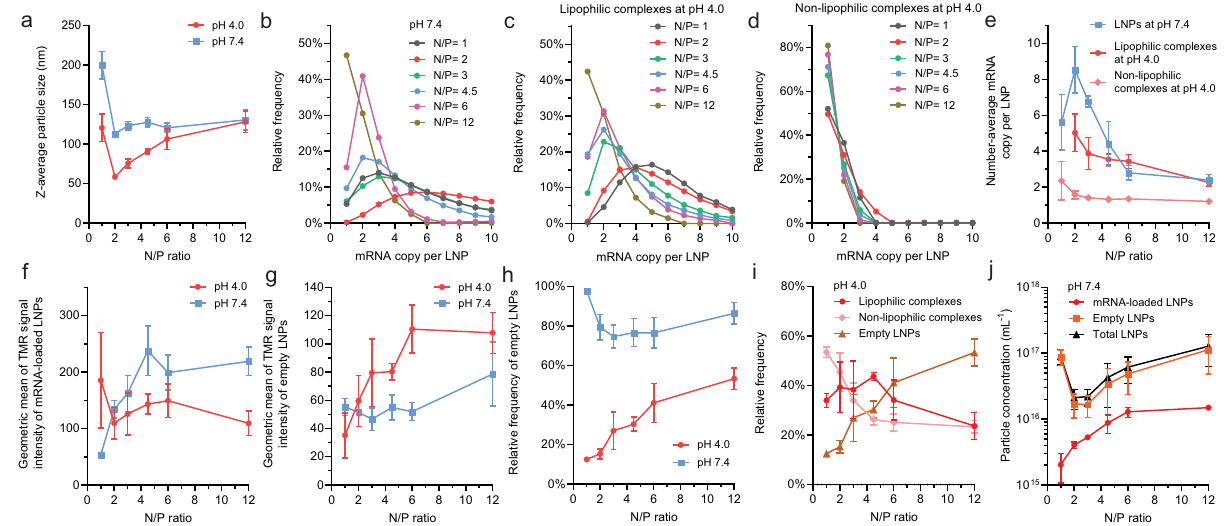
Fig. 5 | Effects of N/P ratio on the payload capacity and lipid content of mRNA LNPs. a The z-average particle size of mRNA LNPs assessed by dynamic light scattering(DLS). b – d ThemRNApayloaddistributionpro fi lesofformulationsatpH 7.4 b ; pH 4.0 for lipophilic complexes c ; or pH 4.0 for non-lipophilic complexes d . e The number-average mRNA copy per LNP at either pH 4.0 or pH 7.4. f , g Geometric mean of TMR signals (indicator of relative helper lipid content) of and then applying CICS analysis), except for N/P ratio=6 where n